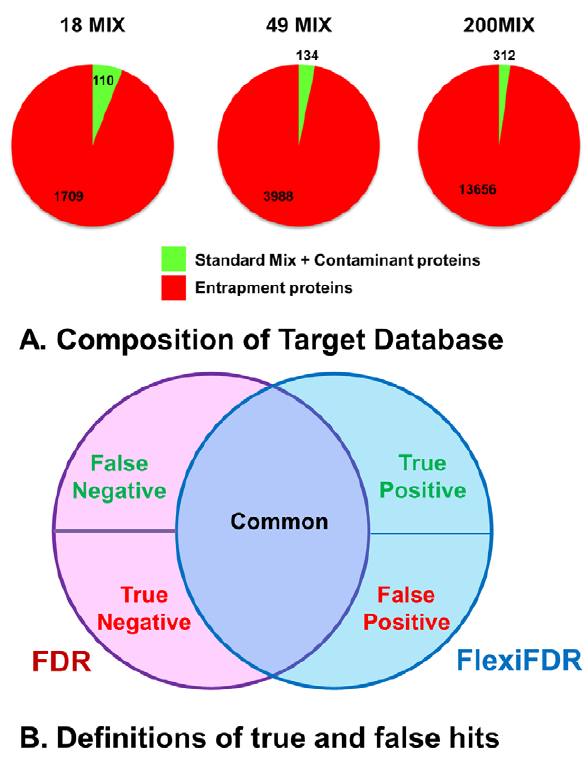
Figure 2. Database composition and evaluation terminology. (A) The composition of databases used for searching standard mix datasets is shown. Database consists of standard mix proteins and common contaminants, both of which are considered true proteins (shown in green). It also consists of sequences from an unrelated organism which represent the entrapment sequences or false proteins (shown in red). The sizes of these two parts show that the true proteins were outnumbered by entrapment sequences. (B) For evaluating the FlexiFDR method, the definitions of true and false positives and negatives are relative to the unique sets identified by only one method- either FDR or FlexiFDR.